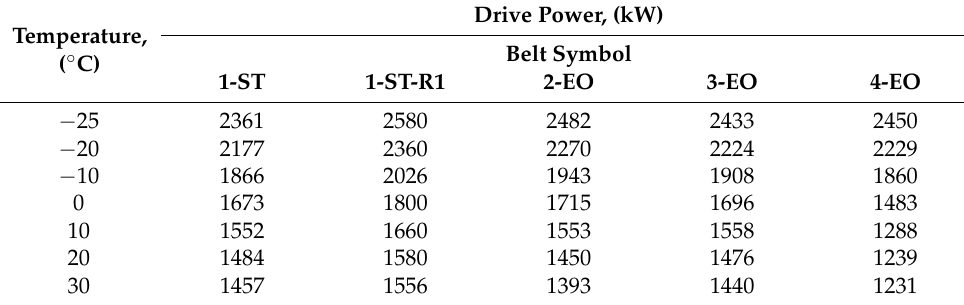
Table 9. Calculation results for the conveyor drive